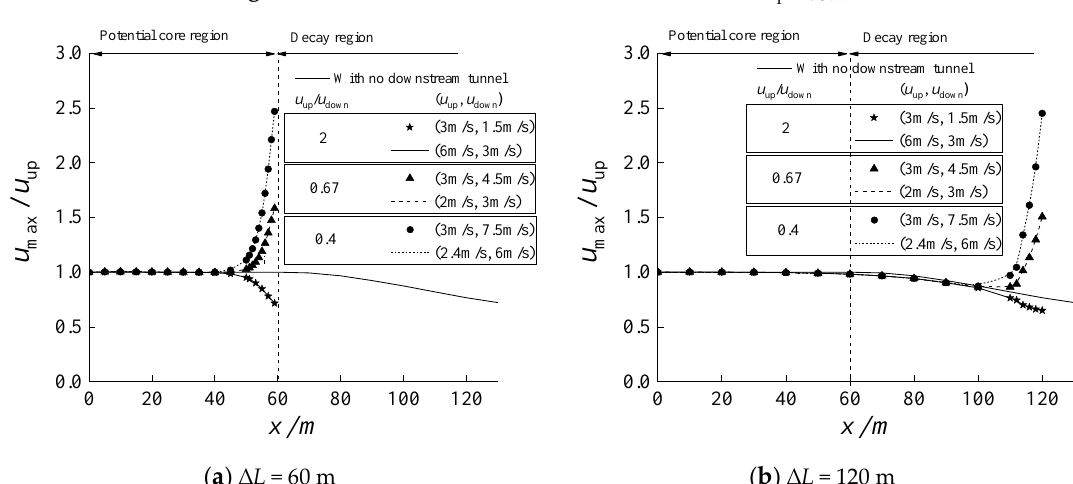
Figure 6. Distribution of u max in the symmetric plane of upstream exit jet for different values of u down .